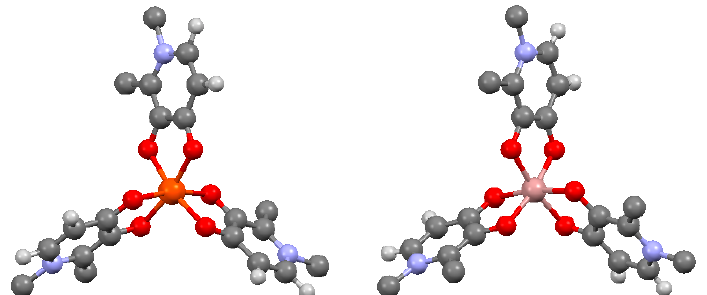
Figure 3. Representations of the molecular structures of [Fe(deferiprone) 3 ] [31] (CCDC number 1183332) ( left ) and [Ga(deferiprone) 3 ] (CCDC number 1164388) [29] ( right ). Only one stereoisomer is depicted for each complex. Orange—iron, pink—gallium, blue—ni trogen, grey—carbon, red—oxygen, and white—hydrogen. These diagrams (generated in Mercury software courtesy of the Cambridge Crystal Database) represent crystallographically determined structures. Hydrogen atoms of methyl groups are omitted for clarity.